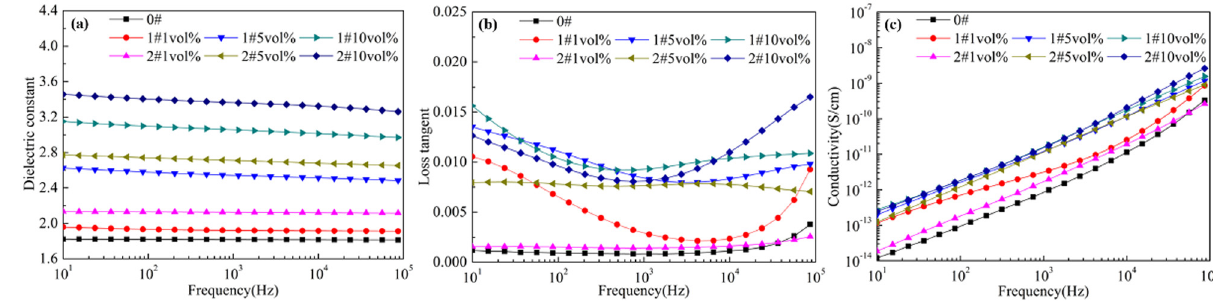
Figure 4: Dependence of ( a ) dielectric constant, ( b ) loss tangent, and ( c ) conductivity of CCTO/LDPE and CCTZO/LDPE composites with di ff erent volume fractions on